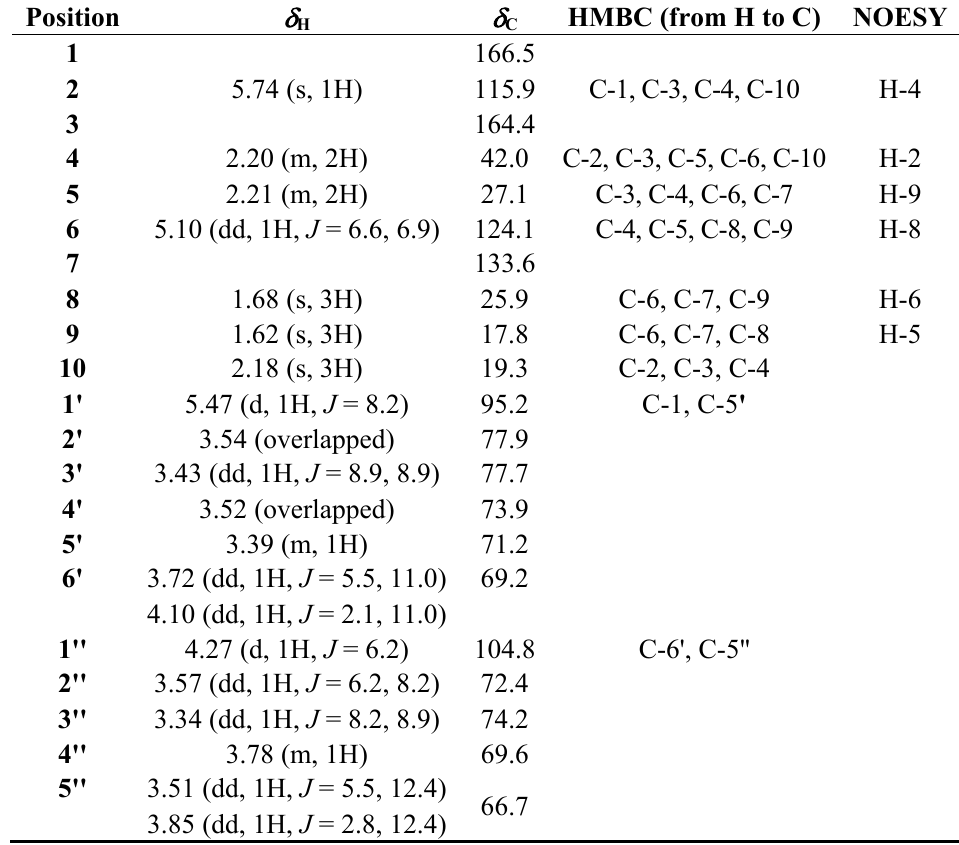
OD, J in Hertz and  in 3